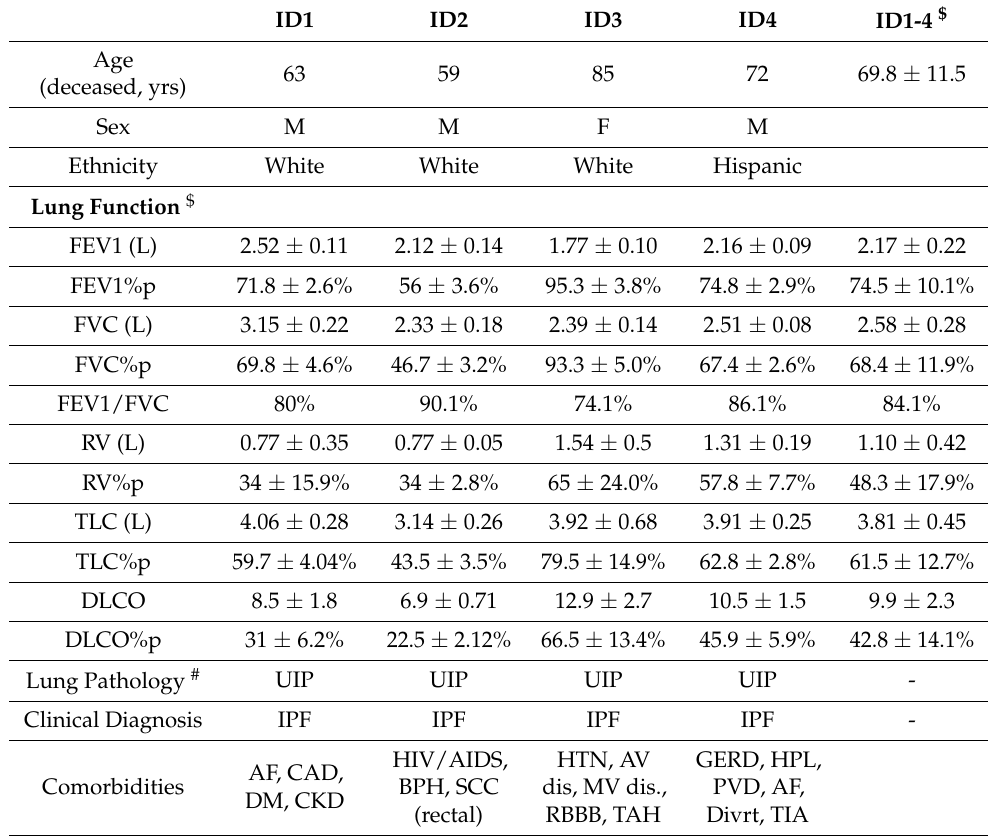
(Table 1). De-identified lung function data obtained at the U.C. Davis Pulmonary Function Lab are also included in Table 1. Table 1. IPF Patient Demographics and